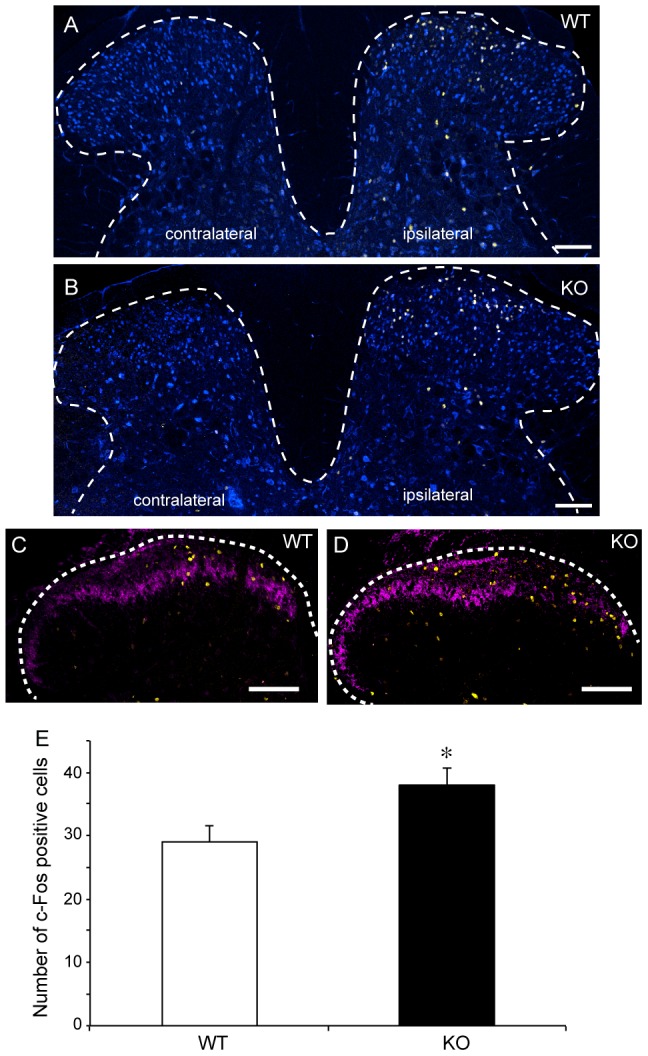
The number of c-Fos-positive neurons in the SR-KO mice significantly increased after the formalin test.(A, B) Immunohistochemical analysis indicates that formalin injected into the left hind paw induced c-Fos protein signals (yellow) in the ipsilateral dorsal horn neurons detected together with NeuN signals (blue) in the WT (A) and SR-KO (B) mice. The c-Fos-positive neurons are mainly distributed in the superficial layers in the dorsal horn. Bars indicate 100 µm. (C, D) Double fluorescence staining with IB4 (magenta) indicates that the c-Fos-positive (yellow) neurons are mainly distributed in laminae I-II of the dorsal horn. Bars indicate 100 µm. Dotted lines in A - D are the outline of the gray matter of the spinal cord. (E) The number of c-Fos-positive cells in laminae I-II significantly increased in SR-KO mice. Values are the means ± SEM. Data are analyzed using the unpaired t-test; * p<0.05 (n = 5 for WT and SR-KO mice).